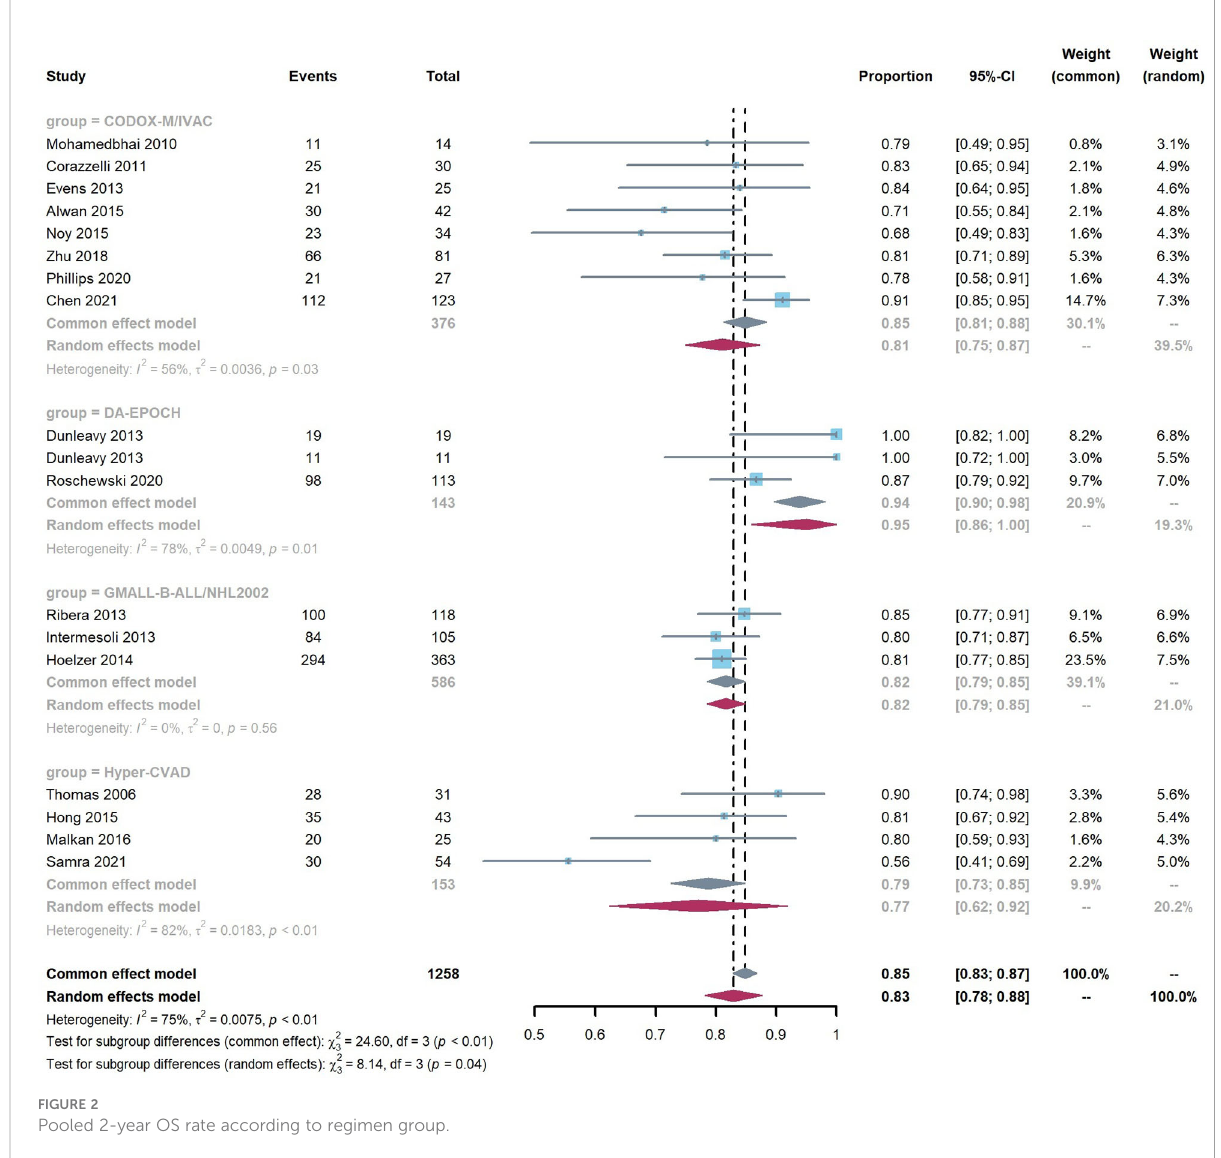
FIGURE 2 Pooled 2-year OS rate according to regimen group.